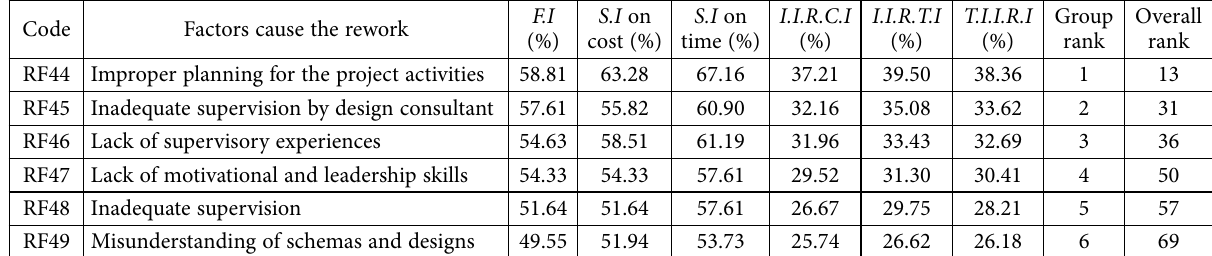
Table 8. Ranking the causes and impact of rework factors related to supervisory Code